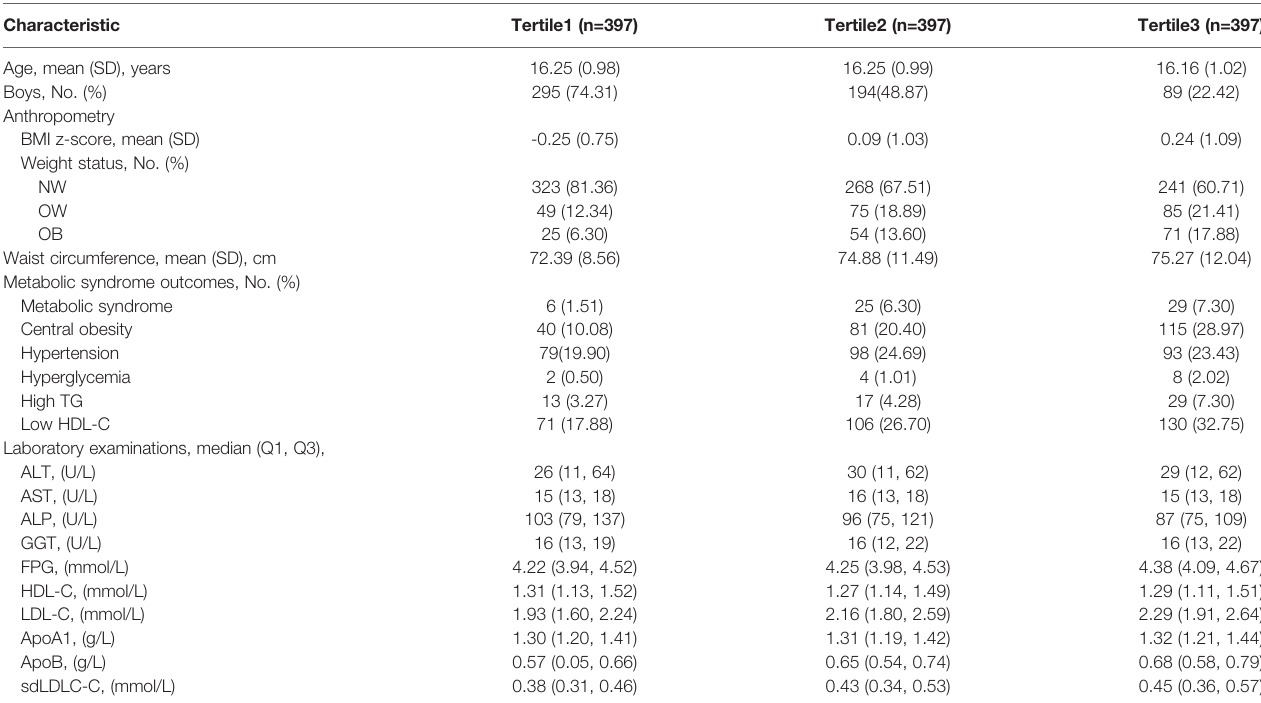
TABLE 1 | Characteristics of the study population according to tertiles of C1q.